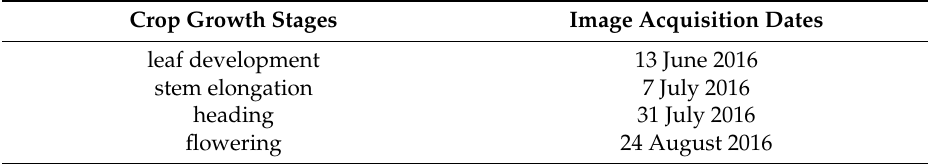
Table 3. Crop growth